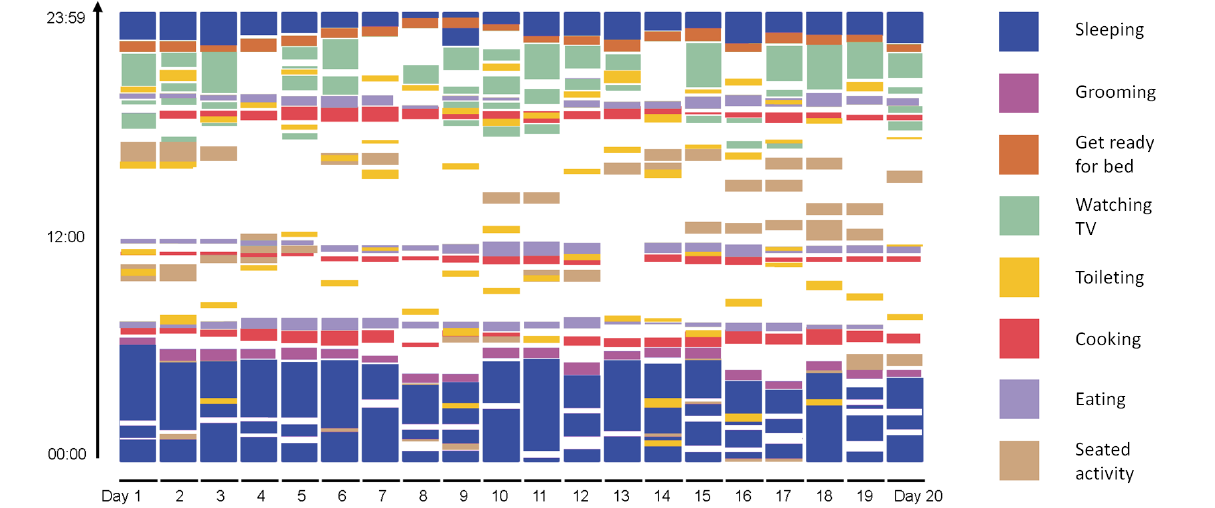
Figure 8. Activity map of healthy 79-year-old